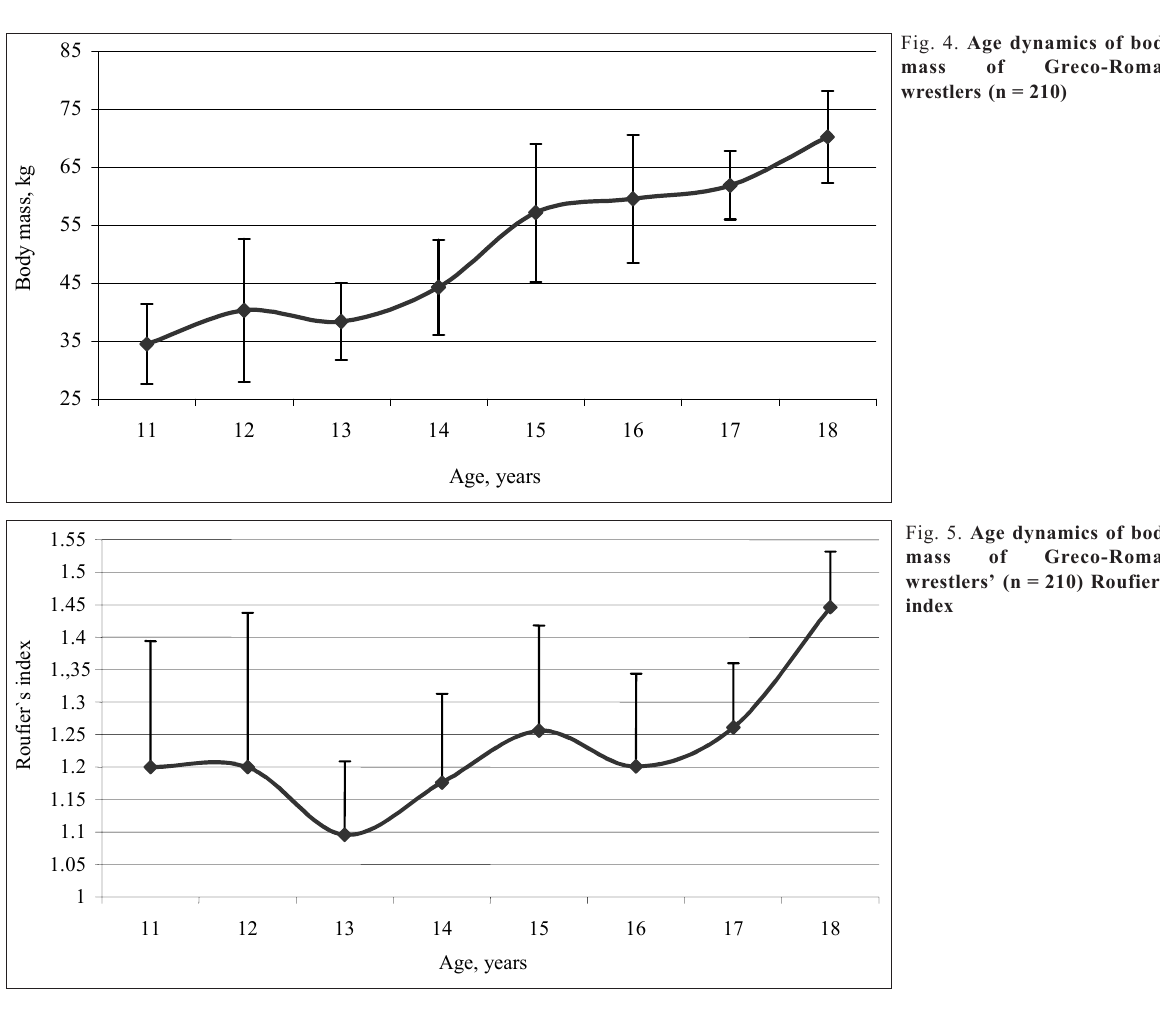
Fig. 5. Age dynamics of body